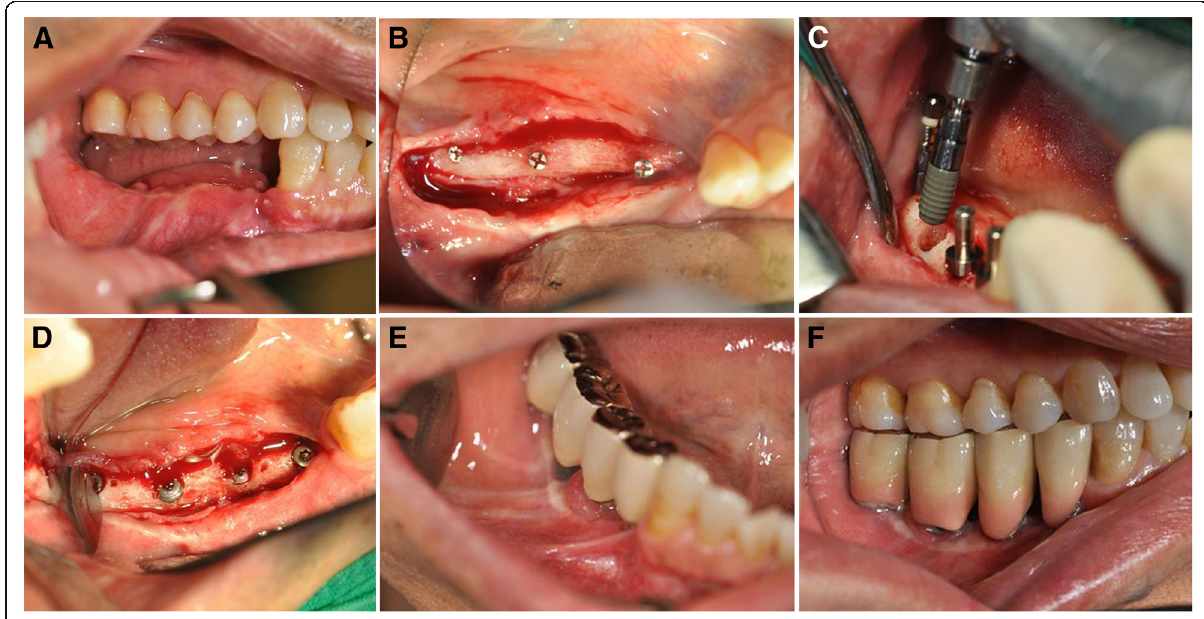
Fig. 3 Clinical views of patient no. 07 during implant installation and prosthesis fabrication showing grafted site after 6 months healing ( a ), second stage surgery for screw removal ( b ) and implant fixtures installation ( c , d ), and final prosthesis fabrication ( e , f